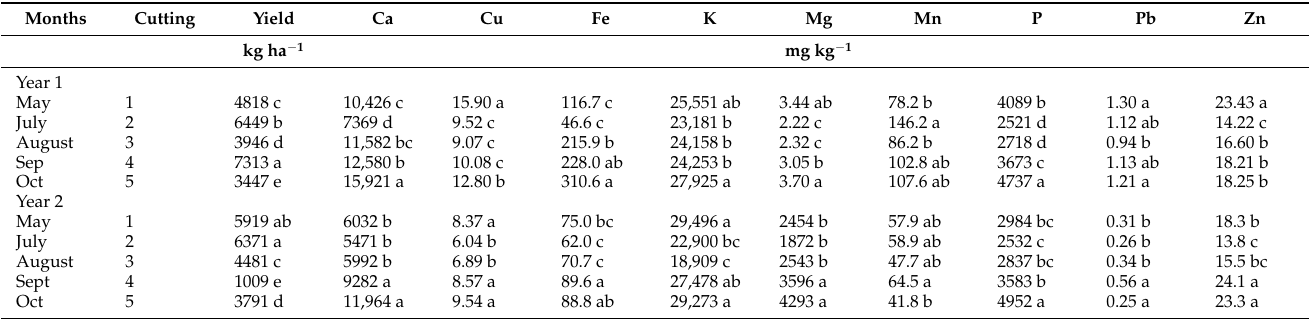
Table 4. Nutrient and metal concentrations averaged over forage cuttings for the first and second year.